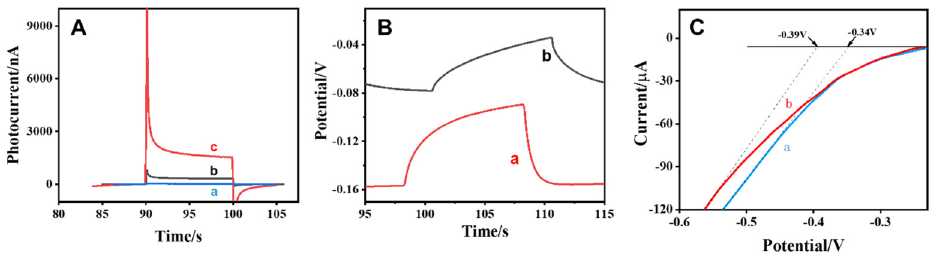
Figure 3. ( A ) Photocurrent responses of (a) Ti 3 C 2 T X (b) Bi 2 S 3 and (c) Bi 2 S 3 /Ti 3 C 2 T; ( B ) OCP response of (a) Bi 2 S 3 and (b) Bi 2 S 3 /Ti 3 C 2 T X MXene; ( C ) LSV responses of (a) Bi 2 S 3 /Ti 3 C 2 T X and (b) Bi 2 S 3 .